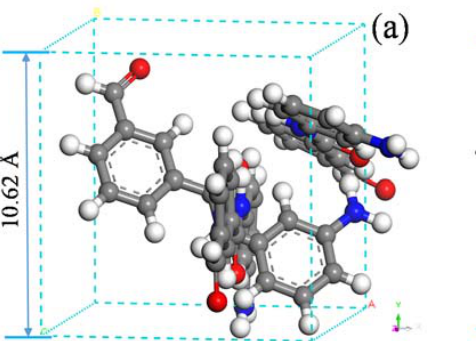
Figure 2. Models of meta-aramid fiber before and after optimization: ( a ) initial 3-PMIA model, ( b ) optimized 3-PMIA model, ( c ) initial 30-PMIA model, ( d ) optimized 30-PMIA model. To ensure the balanced state of the constructed model and obtain a simulation system with a rational configuration, structural optimization of the meta-aramid fiber model was first performed using 5000 structural iterative steps. An annealing cycle treatment was then performed in the temperature range of 300 K–1000 K. A 500-ps relaxation process was then performed. Following these